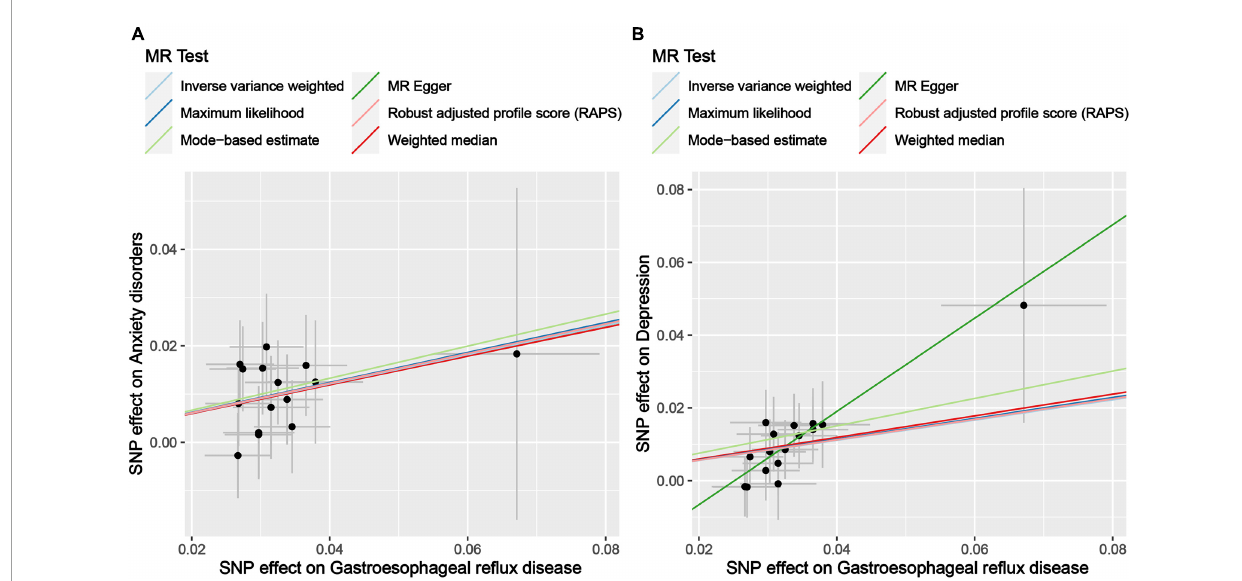
FIGURE2 Scatter plot of genetic correlations of exposure and outcome based on the IVs screened under the genome-wide significance threshold. (A) Scatter plot of genetic correlations of GERD and anxiety disorders. (B) Scatter plot of genetic correlations of GERD and depression.